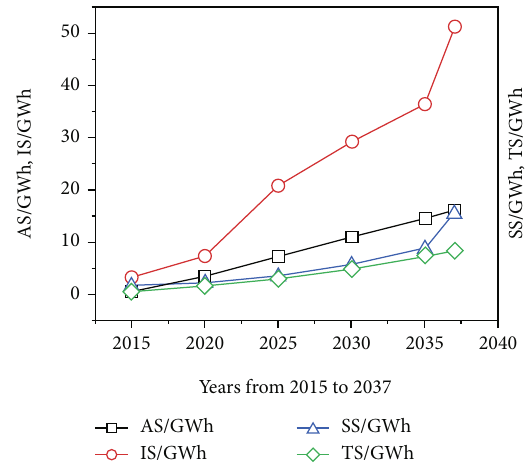
Figure 4: Energy demand forecast of the following sectors (demand forecast in GWh from 2015 to 2037 [19]): AS: agricultural sector; IS: industry sector; SS: service sector; TS: transport